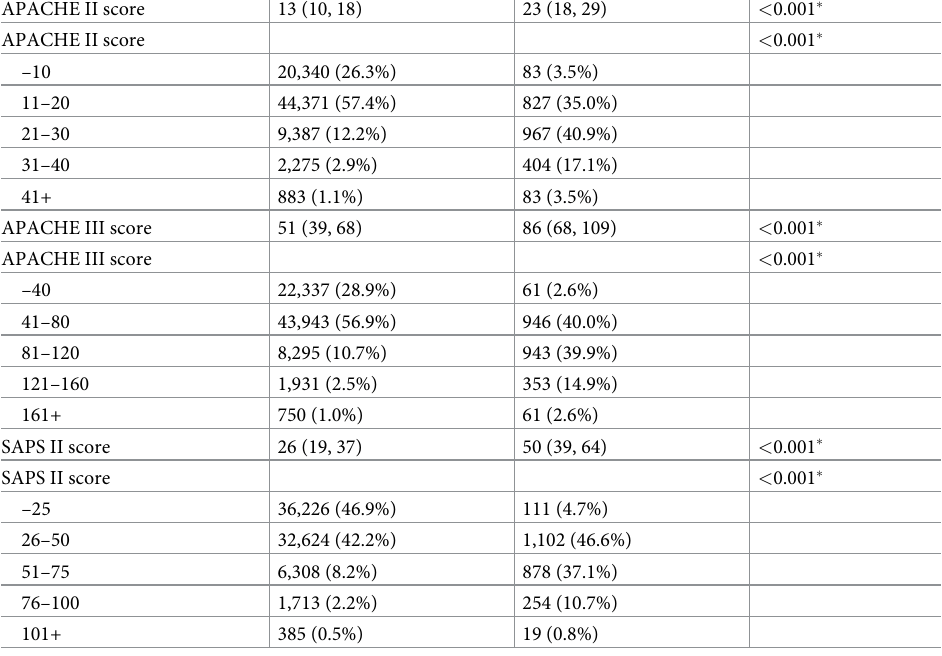
disease, post-operative urinary disease, post-operative muscle/bone/skin disease, post-opera- tive obstetrics/gynecological disease, and non-operative metabolic disease) were significantly associated with lower risk of prolonged ICU stay (Table 5, Model 1). The AUC value of this model was 0.827 (Fig 3, Model 1).